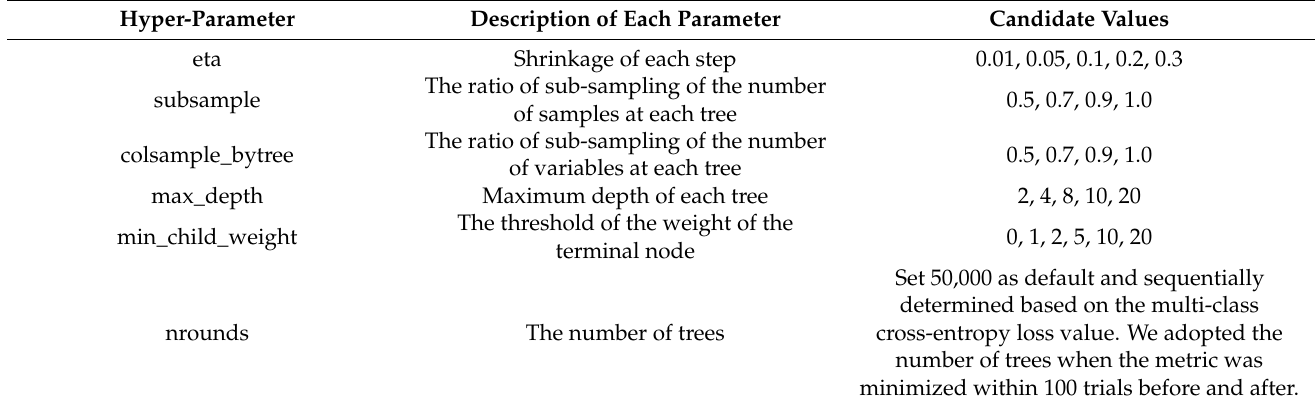
Table 3. Description of each tuned hyper-parameter and candidate value for the grid search. We constructed the model with all parameter combinations, calculated the multi-class cross-entropy value, and adopted the combination of the parameters that resulted in the smallest multi-class cross-entropy value. Table S3 shows the combination of the tuned hyper-parameters for the models constructed using the VI_TEX_SAR data set, which achieved the highest classification accuracy in this